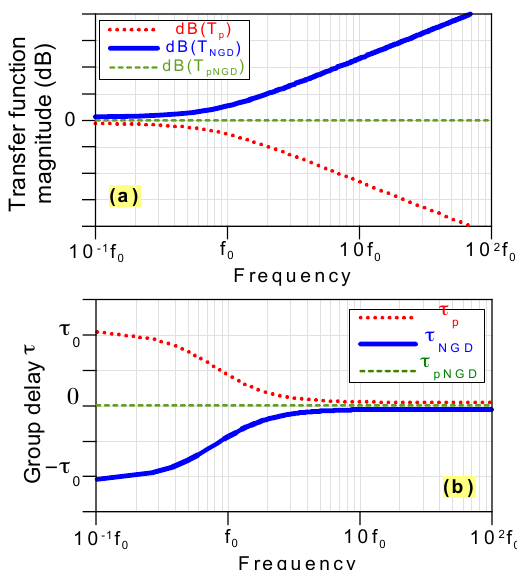
Figure 12: Illustration of the neutralization principle with frequency responses. (a) Magnitude and (b) group delay of the transfer functions T for the NGD circuit and T